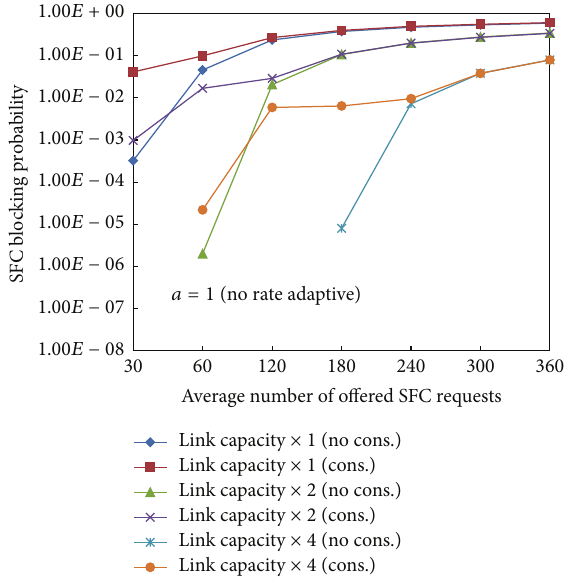
Figure 9: SFC blocking probability as a function of the average number of SFCs offered in the PHI for the cases in which the consolidation technique is applied and it is not. The server power consumption is constant ( 𝑎 = 1